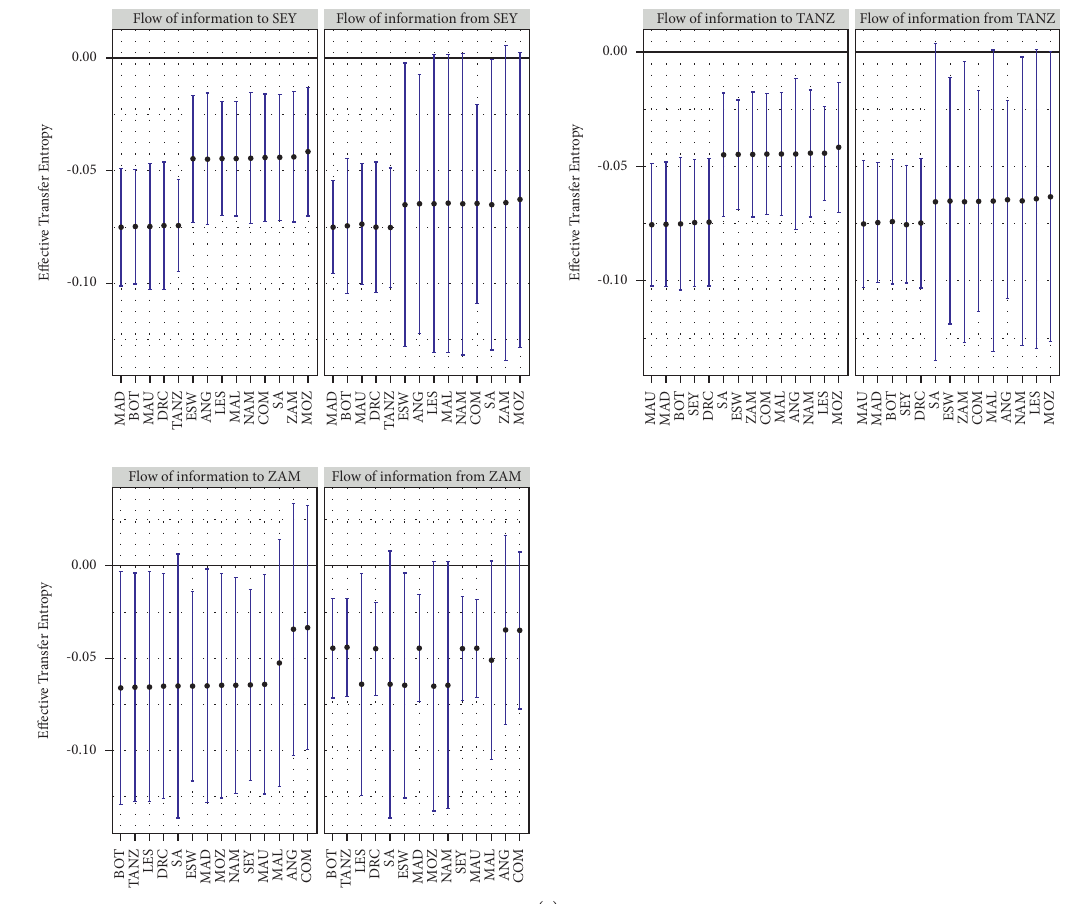
Figure 5: Information flow between exchange rates at the